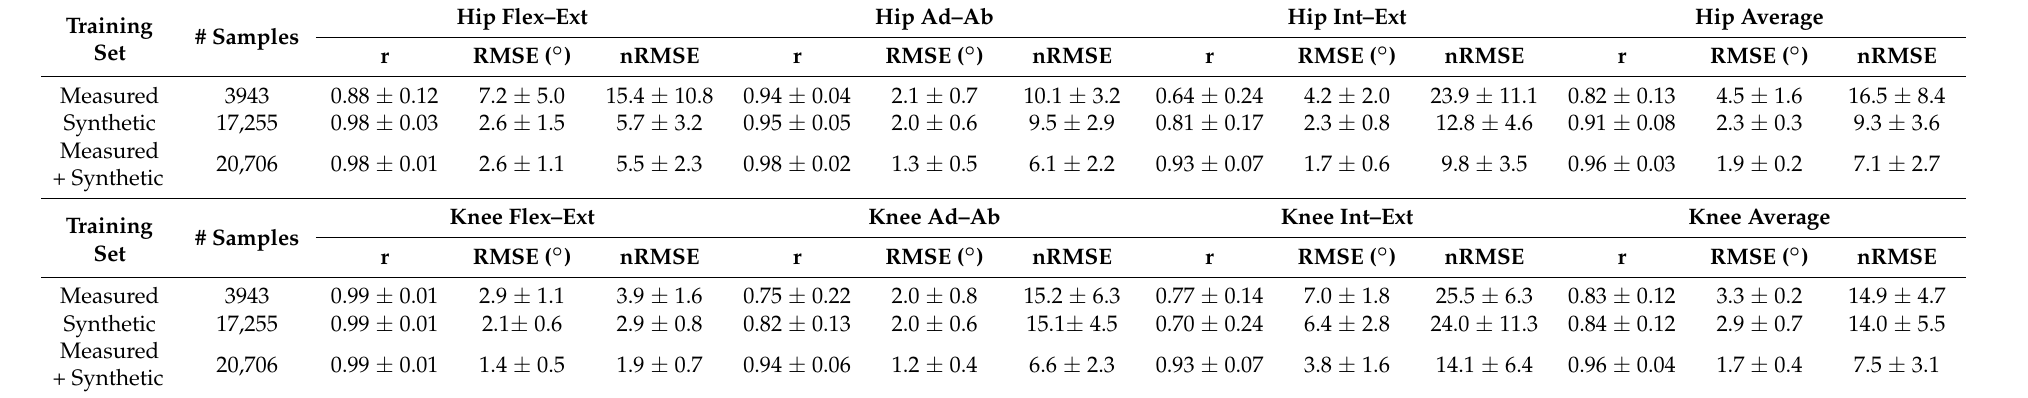
Table 3. Model prediction accuracy for hip and knee joint angles with different sets of training data: measured data, synthetic data, and combined measured and synthetic data. Accuracy metrics include the Pearson correlation coefficient (r), root mean square error (RMSE), and normalized root mean square error